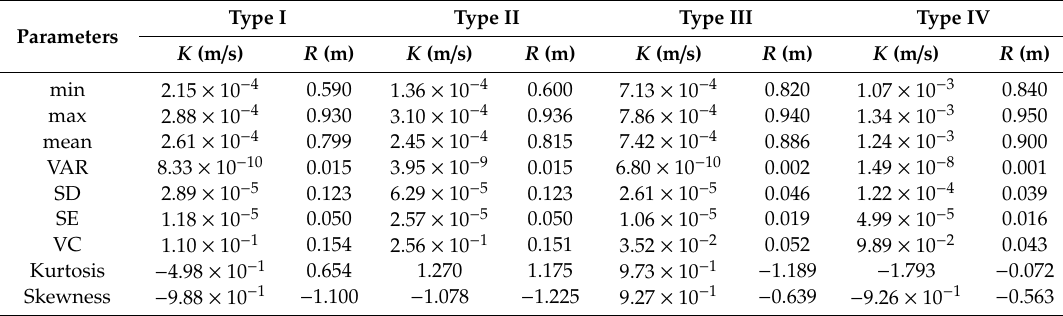
Table 4. Main statistical parameters relative to the sets of K and R values for each configuration. Parameters